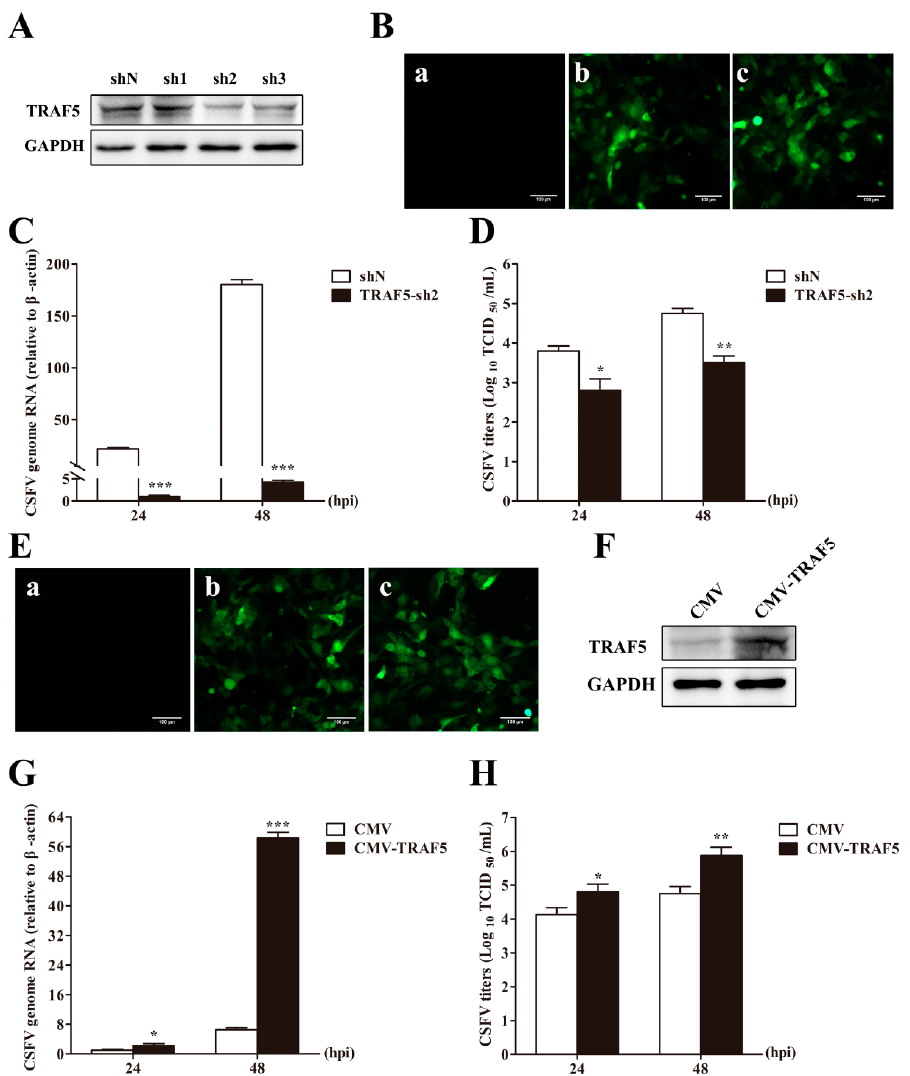
Figure 2. TRAF5 promotes CSFV replication. ( A ) Western blot analysis of knockdown efficiency of three TRAF5 knockdown vectors. PAMs were transfected with TRAF5-sh1, TRAF5-sh2, TRAF5-sh3, or shN. At 48 h post transfection (hpt), the cell lysates were collected and endogenous TRAF5 expression was determined by Western blot. GAPDH was used as an internal control; ( B ) Confirmation of TRAF5-knockdown lentivirus infection by fluorescence detection of the GFP reporter expressed in PAMs. TRAF5-knockdown PAMs were constructed via lentivirus infection. (a) Mock-infected PAMs. (b) PAMs infected with lentiviruses expressing shN. (c) PAMs infected with TRAF5-sh2 lentivirus. Scale bar = 100 μ m for all the figures; ( C ) CSFV genome RNA in TRAF5-sh2 cells. The shN and TRAF5-sh2 cells were infected with CSFV at an MOI of 0.1. CSFV genome RNA levels were determined by RT-qPCR at 24 and 48 hpi; ( D ) Viral titers of infectious progeny in the supernatant from TRAF5-sh2 cells. Viral titers in the culture supernatant collected at 24 and 48 hpi were determined and expressed as TCID 50 /mL; ( E ) Confirmation of CMV-TRAF5 recombinant lentivirus infection by fluorescence detection of the GFP reporter expressed in PAMs. (a) Mock-infected PAMs. (b) PAMs infected with lentiviruses expressing CMV. (c) PAMs infected with lentiviruses expressing CMV-TRAF5. Scale bar = 100 μ m for all the figures; ( F ) Western blot for TRAF5 expression in CMV-TRAF5 cells; ( G ) CSFV genome RNA in CMV-TRAF5 cells. The CMV and CMV-TRAF5 cells were infected with CSFV at an MOI of 0.1. CSFV genome RNA levels were determined by RT-qPCR at 24 and 48 hpi; ( H ) Infectious progeny viral titers in supernatants from CMV-TRAF5 cells. Viral titers in the culture supernatant collected at 24 and 48 hpi were determined and expressed as TCID 50 /mL. Error bars represent the mean ± SD of three independent experiments. *, p < 0.05; **, p < 0.01; *** p <